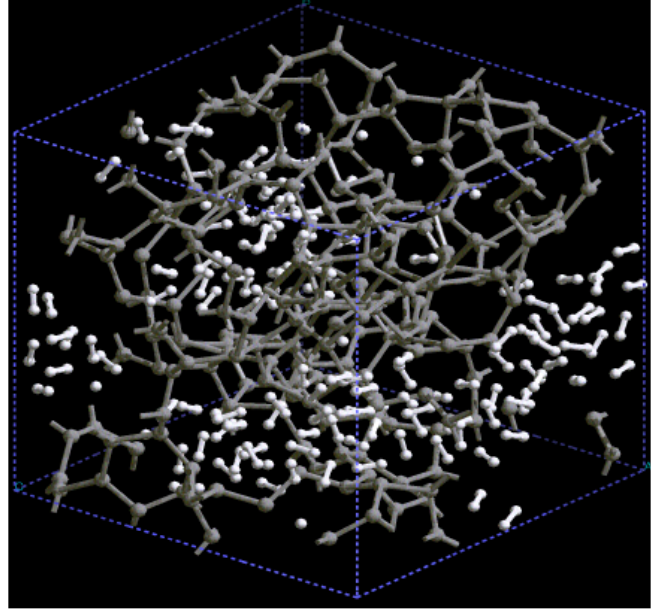
Figure 18. Starting with the relaxed amorphous porous carbon structure, 260/2 hydrogen molecules were constructed within the pore and the supercell was geometry